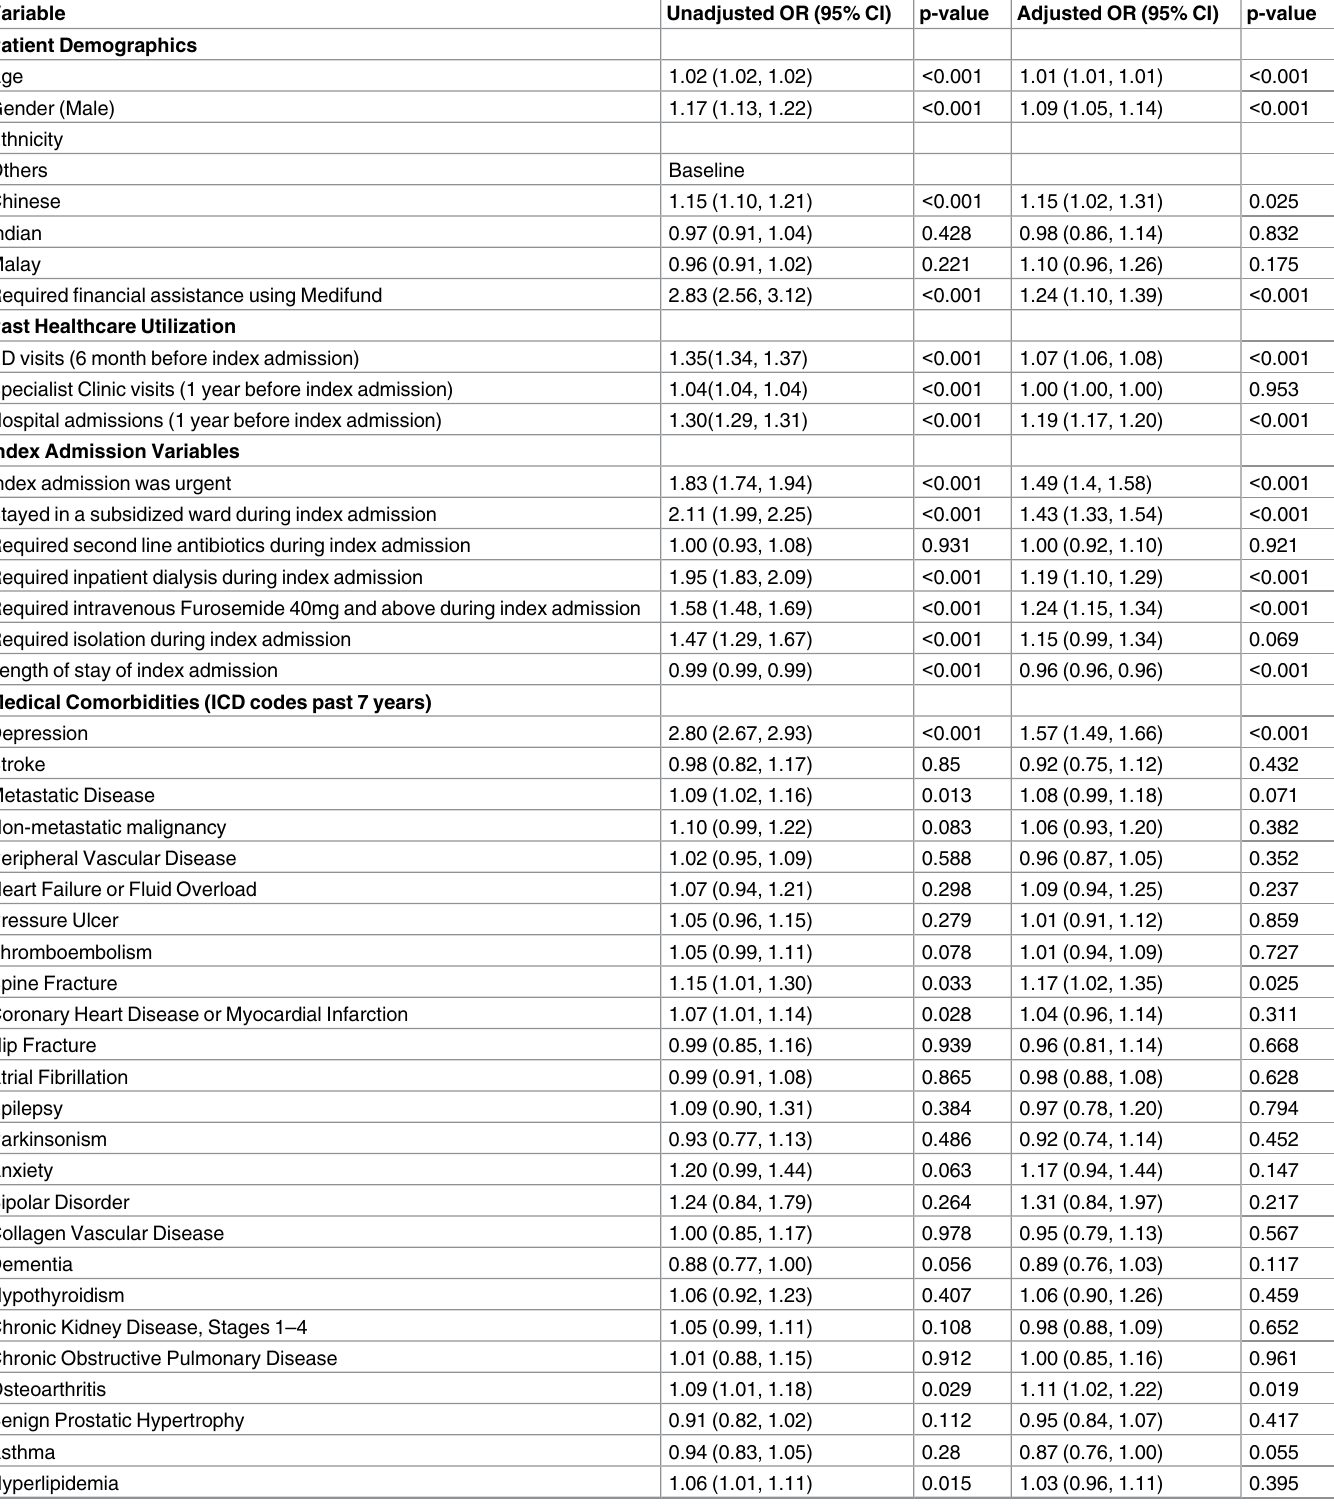
Table 2. Univariable and multivariable logistic